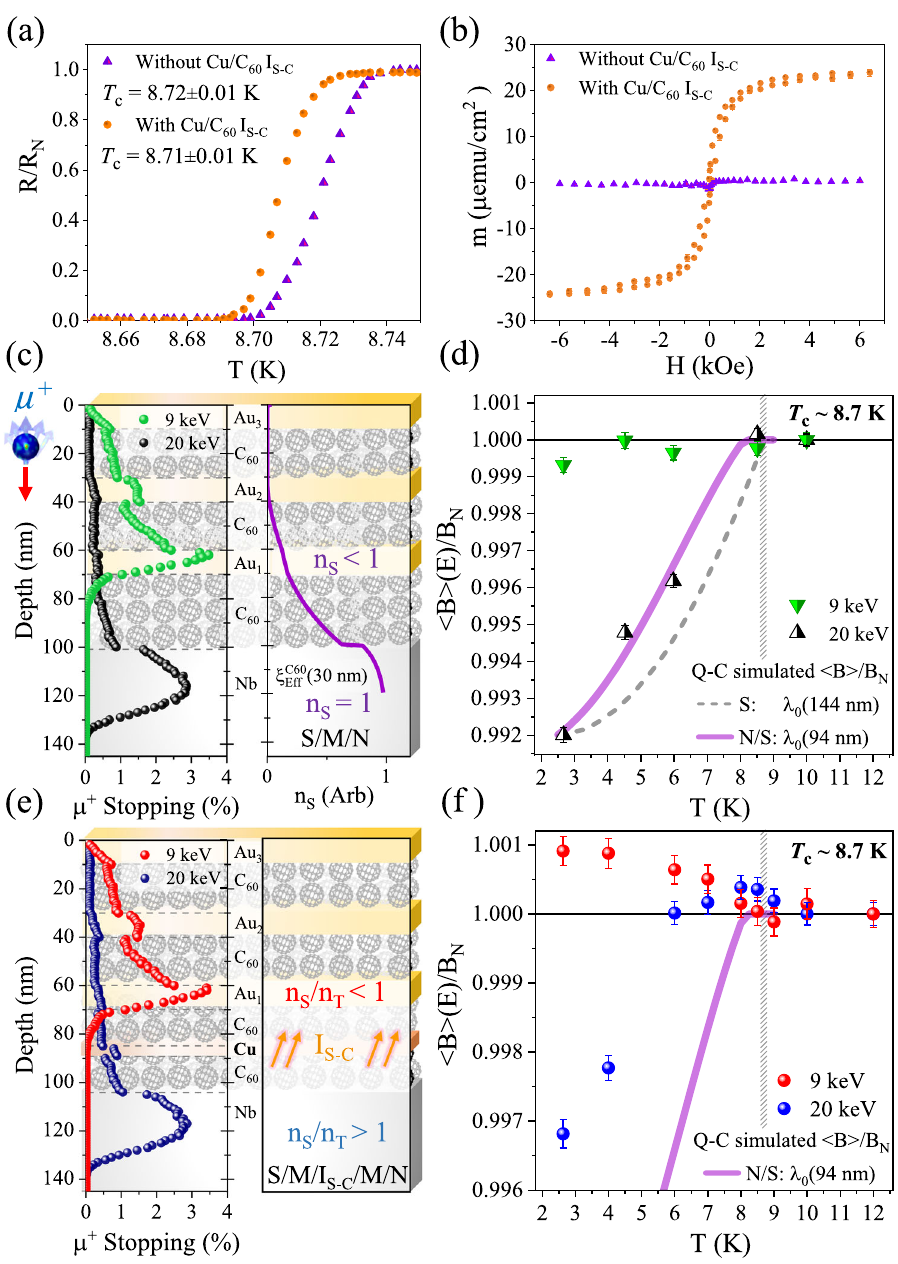
Fig. 4 Low-energy muon spin rotation measurements of screening effects in Multi-Probe hybrid proximity stacks. a The two samples have very similar superconducting transition temperatures ( T c ). b Magnetic hysteresis loops at 300 K for the two Multi-Probe sister samples. The saturation magnetisation per unit area are 24 ± 1 μ emu cm − 2 (with Cu/C 60 ; orange dots) and 0.4 ± 0.2 μ emu cm − 2 (without; purple triangles). c Simulated stopping pro fi les for the superconductor/molecular/normal metal (S/M/N) structure at 9 keV (green symbols) and 20 keV (black symbols). At 9 keV, no muons are implanted into the Nb fi lm; this is also true for the superconductor/molecular/spin-converter interface (S/M/I S – C /M/N) structure in e . d Temperature dependence of the average local fi eld, h B ið E Þ , in a 300 G applied transverse fi eld for the S/M/N structure. Well below T c , a small reduction in h B ið E Þ is observed in the Au layer at 9 keV implantation energy. This small Meissner screening originates from the leakage of Cooper pair states through the C 60 and into the Au layer. At 20 keV, muons stop exclusively in the Nb layer, and a large conventional Meissner effect is observed. e Simulated stopping pro fi les at 9 keV (red symbols) and 20 keV (blue symbols) show that the depth dependence of the muon implantation is mostly unaffected by the inclusion of the spin-converter layer. f The temperature dependence of the measured local fi eld in a 300 G applied transverse fi eld for the S/M/I S – C /M/N structure. Below T c , an increase in B is observed in the Au layer at 9 keV (red symbols) due to the presence of odd-parity pairs. At 20 keV (blue symbols), the conventional Meissner effect is roughly half compared to the sample without the spin-converter Cu/C 60 interface. Error bars are statistical variations over 5 million muon decay